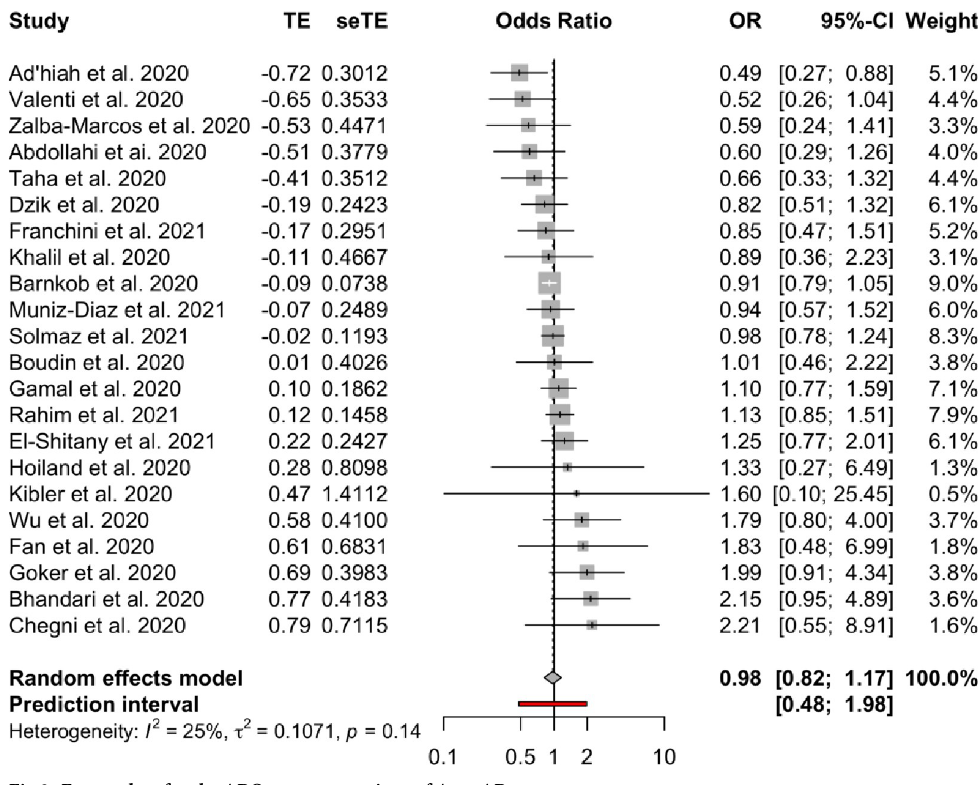
PLOS ONE | https://doi.org/10.1371/journal.pone.0271451 July 28,